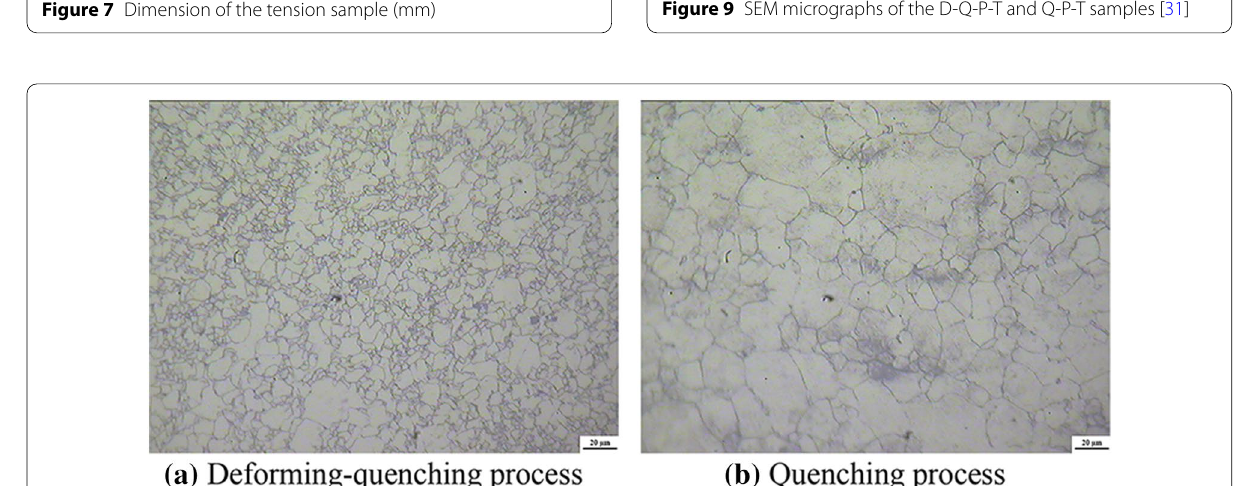
Figure 8 Optical micrographs of the D-Q-P-T and Q-P-T samples [31]